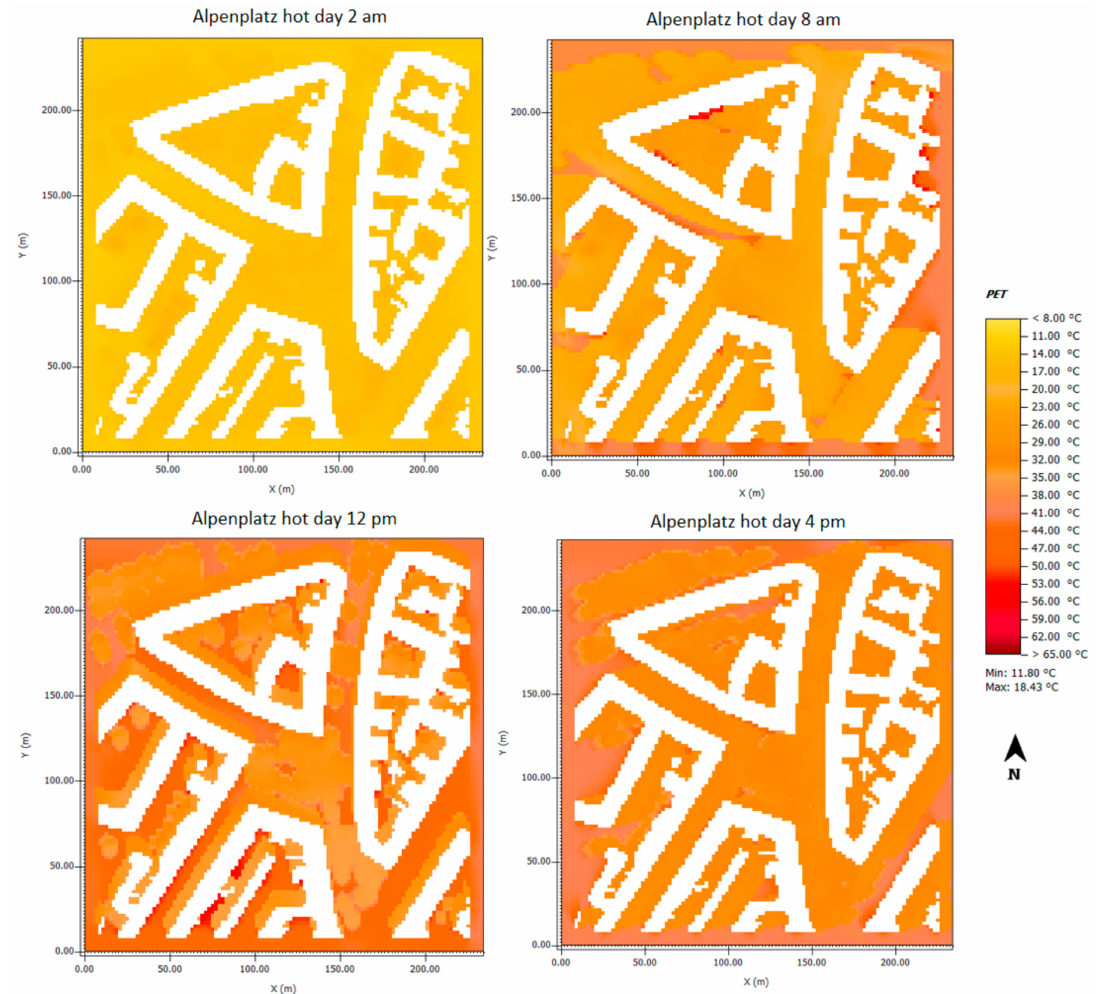
Figure 8. Alpenplatz’s PET variation during the hot day (2 am, 8 am, 12 pm, 4 pm). On the hot day, despite the high amount of vegetation at Bordeauxplatz, the simulation results revealed strong thermal stress conditions (mean PET 40.3 ◦ C) during the critical period analyzed (12 pm and 4 pm). As also seen at Alter Hof, the highest PET value (20.5 ◦ C) was observed under the trees at night. The double effect of the shading from the trees and from the buildings reduced the PET values in almost the entire canyon at 4 pm (mean PET 38.0 ◦ C). At Hohenzollernplatz, even with the high percentage of a paved area, the shadow effect was responsible throughout the hot day for a mild heat stress condition (mean PET 28.5 ◦